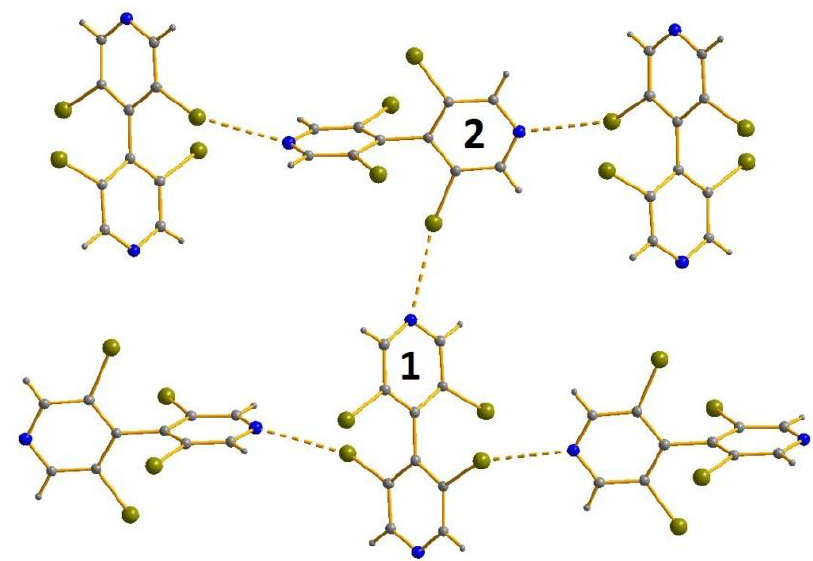
Figure 3. The system of N · · · Br interactions (dashed) in 1 .